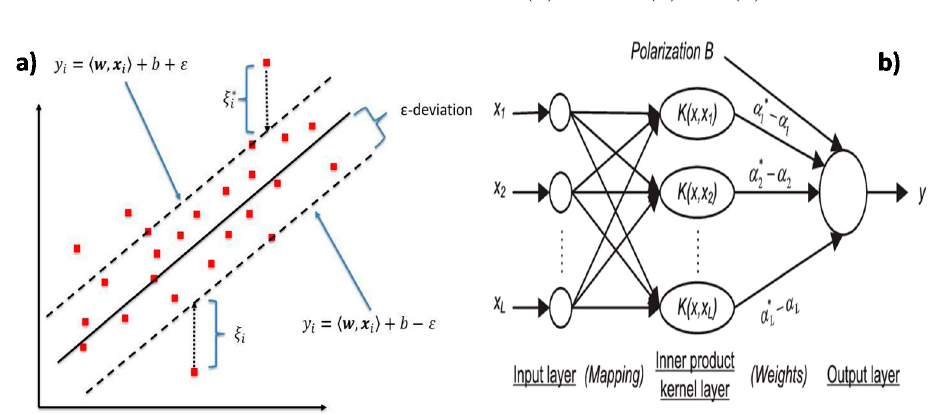
Figure 3. ( a ) Example of support vector regression (SVR); errors do not matter as long as they are less than ε , while the deviations are penalized. ( b ) Typical architecture of an SVR algorithm.